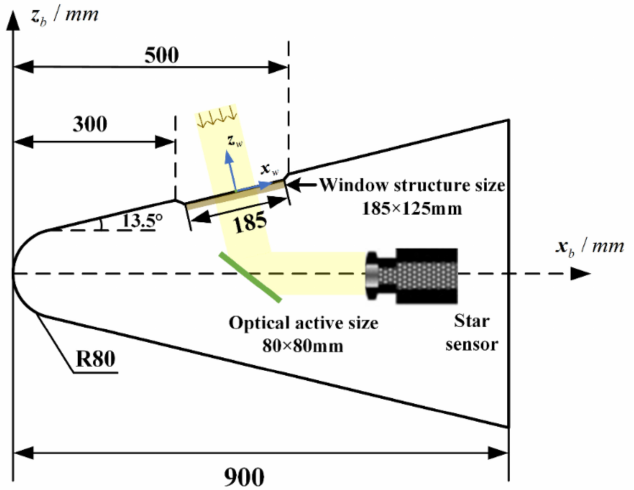
Figure 6. Physical structure diagram of a hypersonic vehicle.